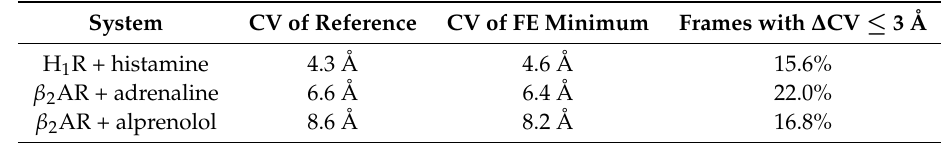
Figure 2. Free energy as a function of the binding CV calculated from the multiple walker metadynamics simulations. In each graph, the global minimum was set to zero. The part of the curve, for which the CV difference ∆ CV to the minimum is less or equal to 3 Å, is colored in red. ( a ) Histamine in complex with the H 1 receptor, ( b ) adrenaline, and ( c ) alprenolol both in complex with the β 2 adrenoceptor. Table 2. Energy minima of the multiple walker metadynamics simulations. The CV values for the global free energy (FE) minima from the simulations are compared with the CV values measured for the reference structures described in Table 1. Moreover, the table lists the percentages of frames from the multiple walker trajectories, which have a CV value within 3 Å of these